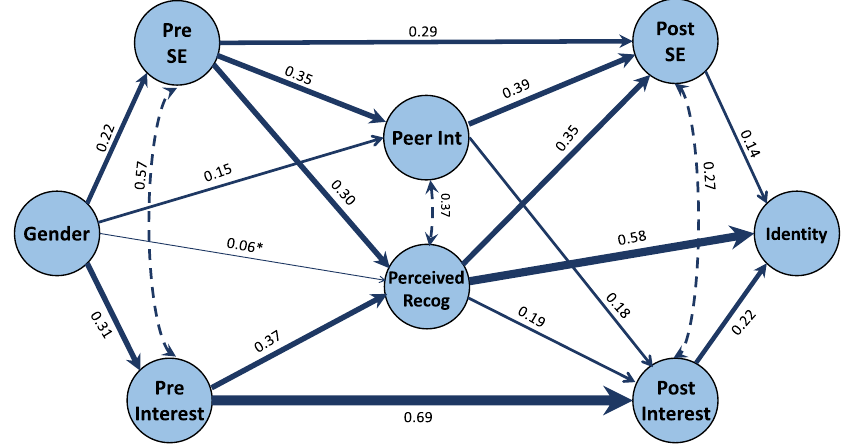
FIG. 3. Schematic diagram of the path analysis part of the structural equation modeling between gender and being a physics person through self-efficacy, interest, perceived recognition, and peer interaction. The solid lines represent regression paths, and the dashed lines represent residual covariances. The regression line thickness corresponds to the magnitude of β value (standardized regression coefficient) with 0 . 01 < p < 0 . 05 indicated by *. Other regression lines show relations with p < 0 . 001 .